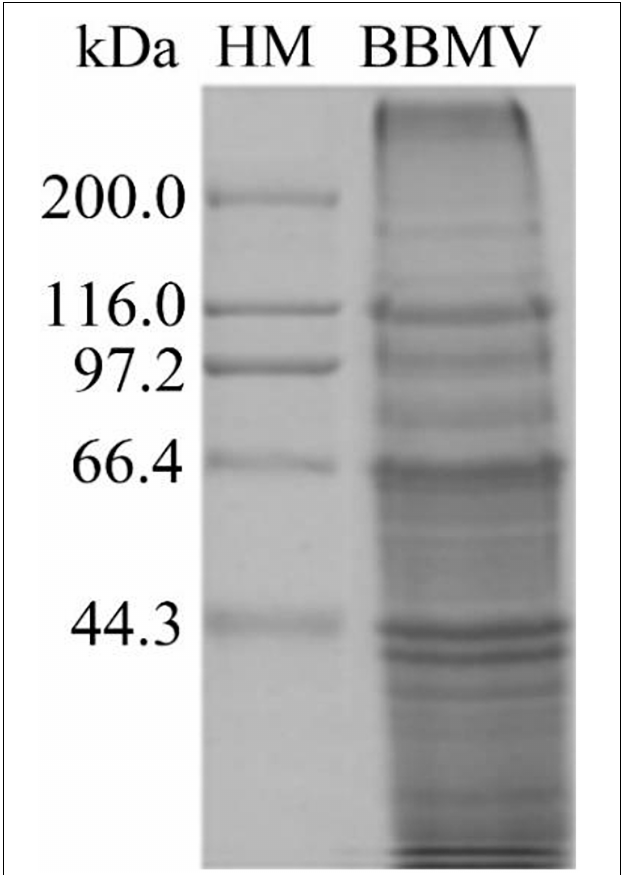
FIGURE 6 | Proteins in C. bowringi BBMV were separated by SDS-PAGE. HM: Protein Molecular Weight Marker (High).